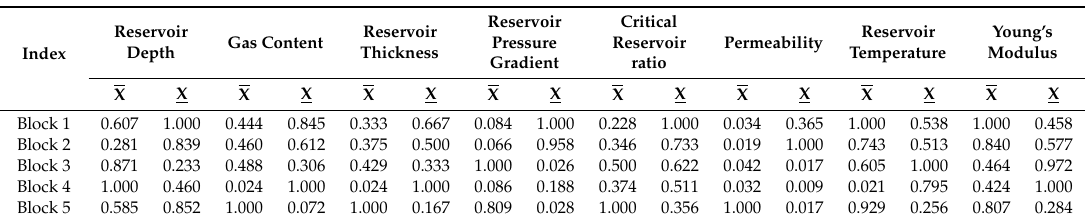
Table 4. Normalization of evaluation indices for upper bound matrix G (7) and lower bound matrix G